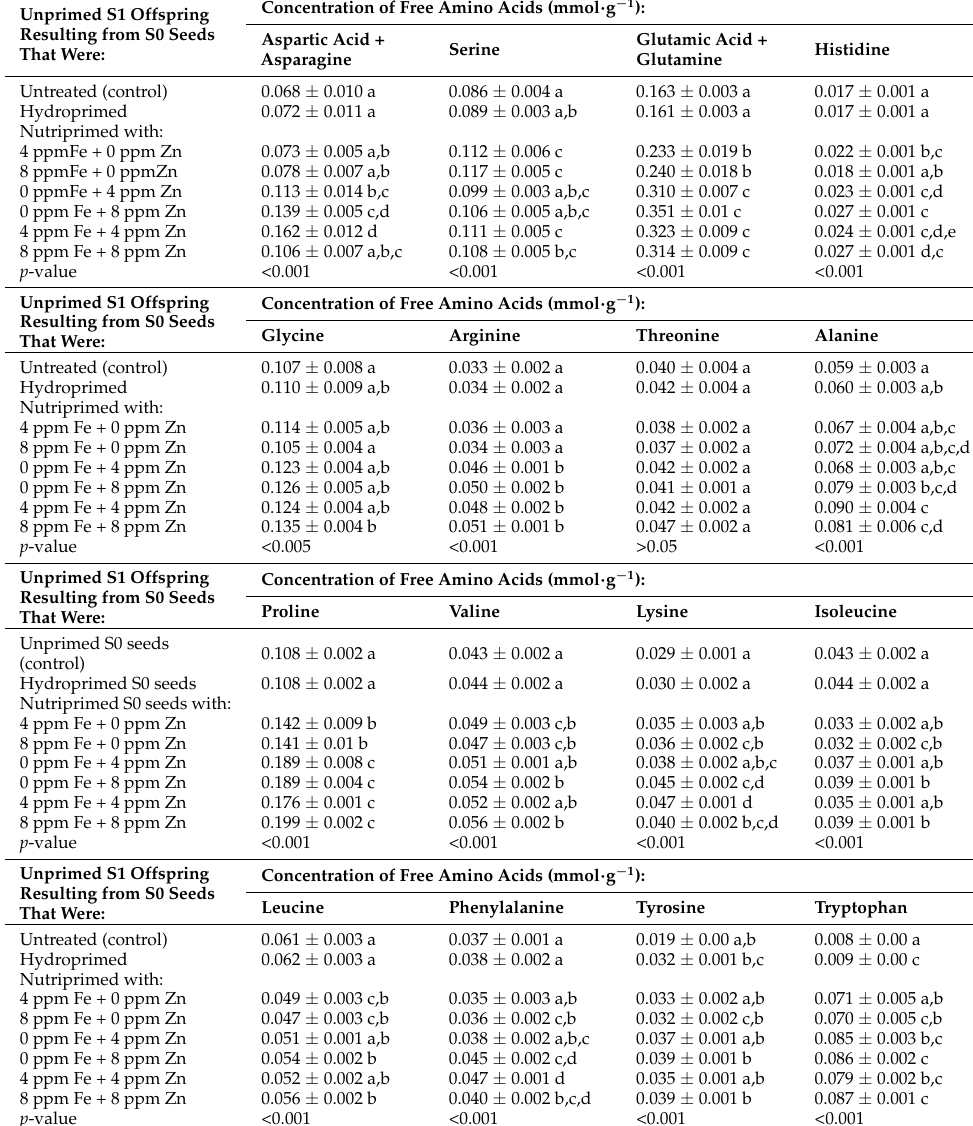
Table 1. Mean ( ± standard error, S.E.) concentration of free amino acids (mmol · g − 1 ) determined per unprimed S1 offspring resulting from S0 seeds that were untreated (control), hydroprimed, or nutriprimed with Fe and/or Zn. The mean values resulted from nine replicates. Values followed by different lowercase letters represent statistically significant differences ( p < 0.05) among S1